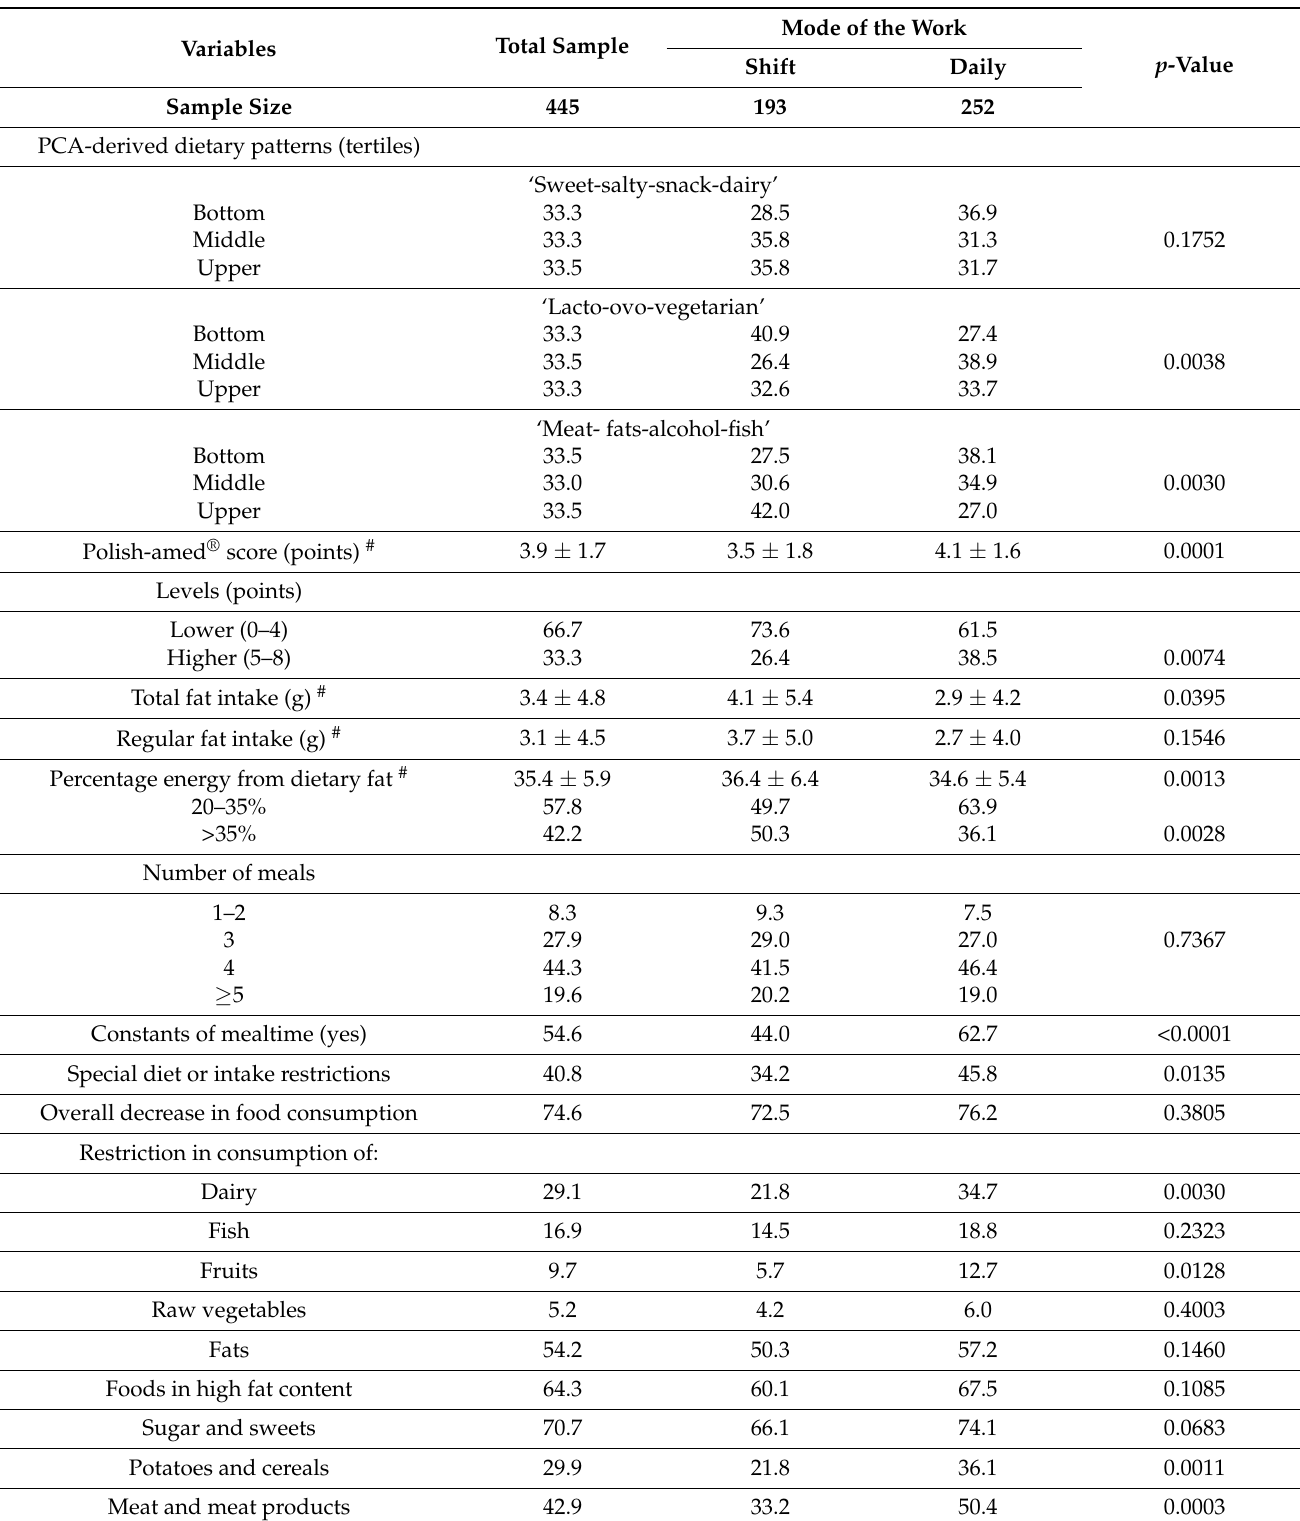
Table 4. Food choices and dietary fat intake in association with the mode of the work among healthcare workers (% or mean ±